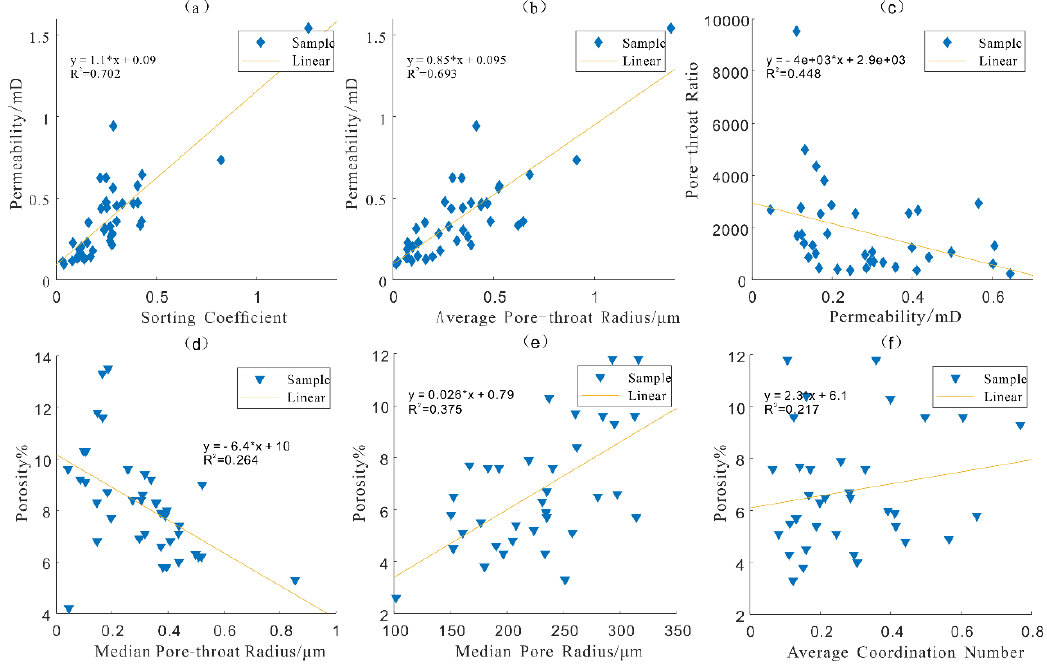
Figure 9. Diagram of different parameters of pore throat and porosity and